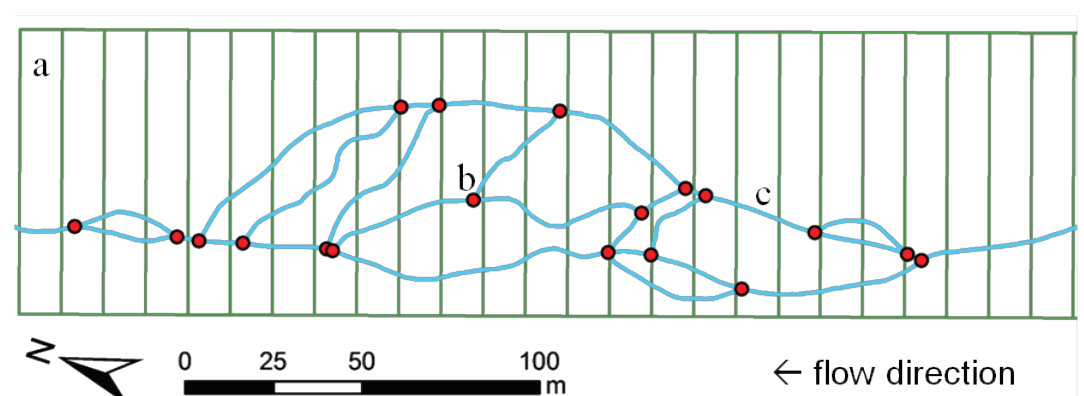
Fig. 2 Analysis of sections for the Channel Count Index; the figure shows the channel pattern on the braid plain in 2010, a = section, b = node, c = channel segment.